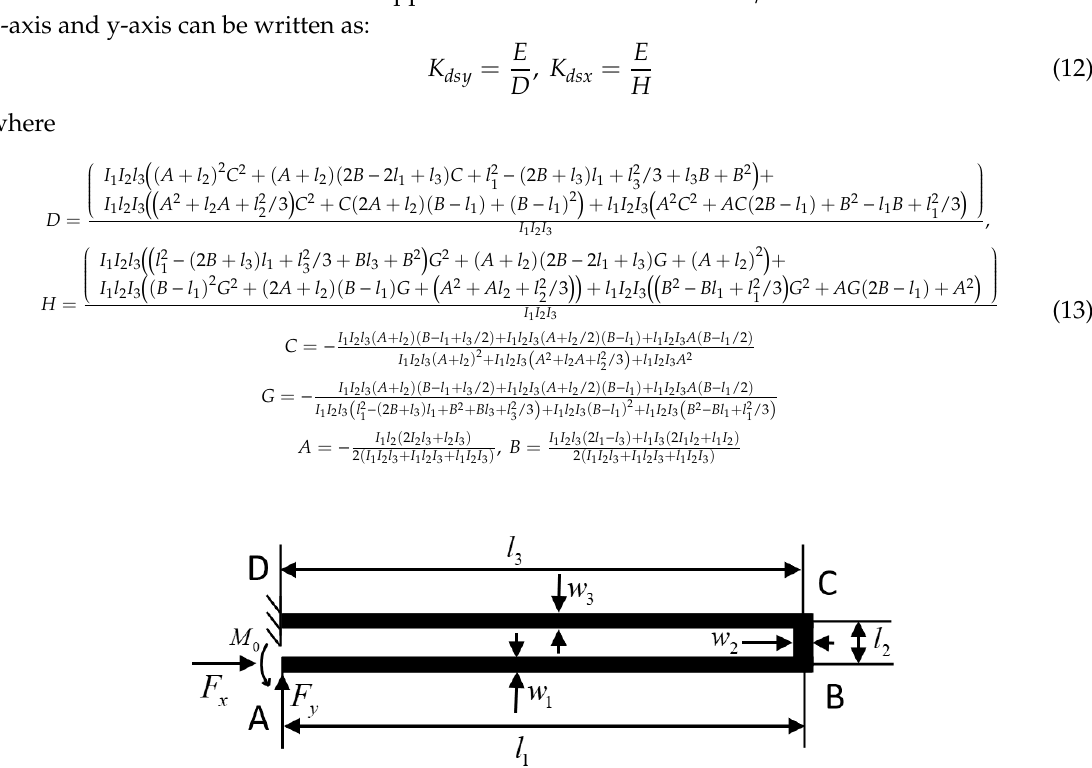
Figure 5. Structure schematic diagram of drive/sense beam.